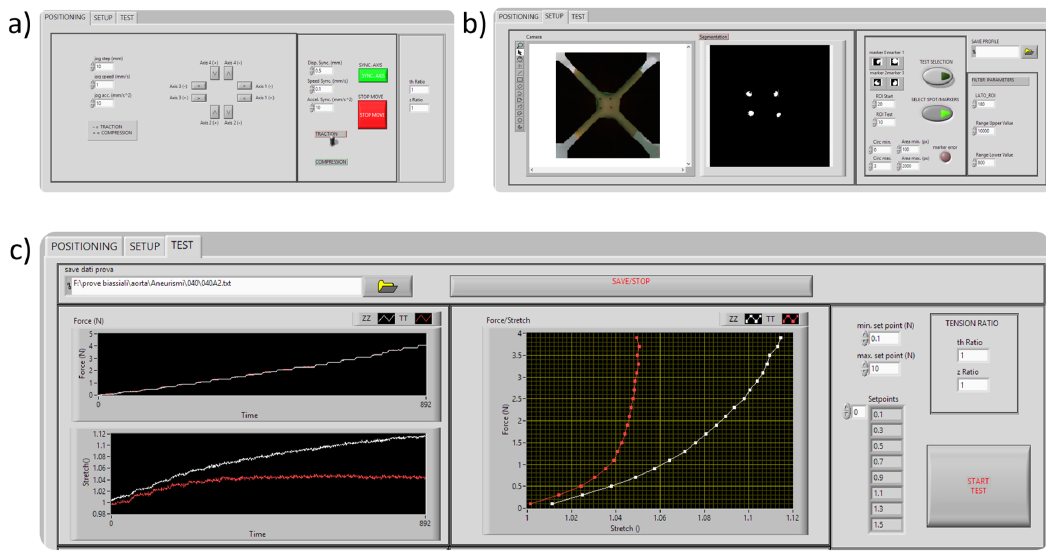
Figure 7. GUI for the TA side including axes jog ( a ), deformation registration ( b ) and tension algorithm configuration and output visualization ( c ).